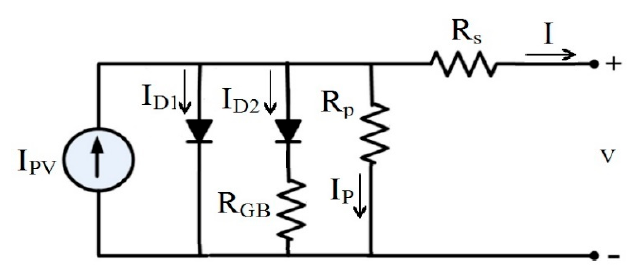
Figure 1. Modified double diode model.